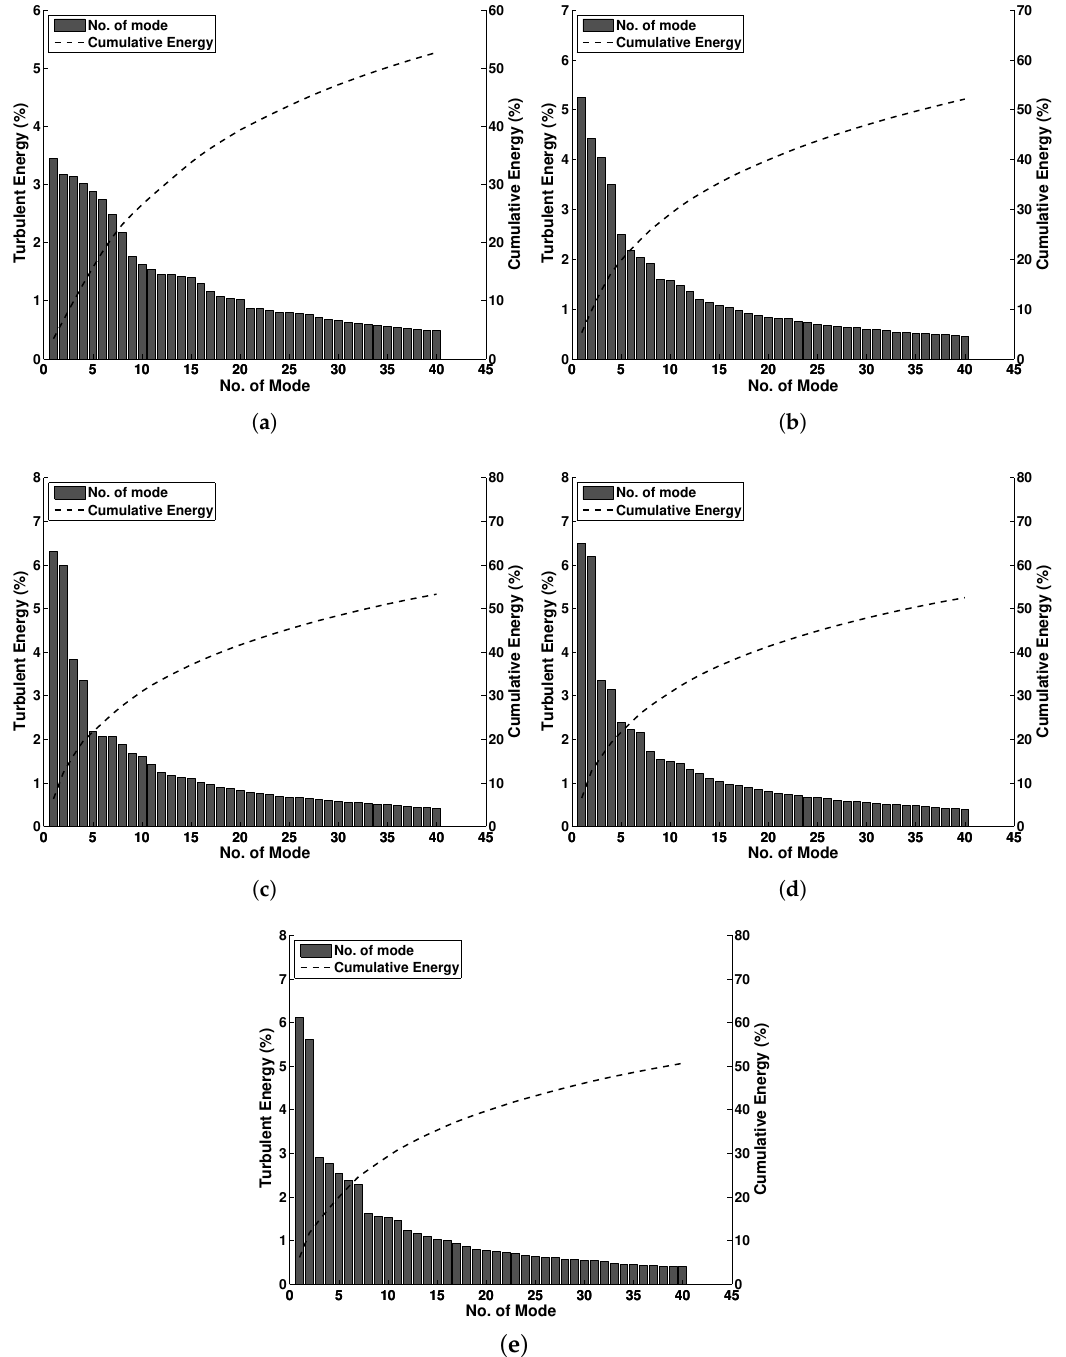
Figure 2. Relative and cumulative turbulent energy distribution in the Proper Orthogonal Decomposition (POD) eigenmodes at ( a ) x / D = 5, ( b ) x / D = 10, ( c ) x / D = 15, ( d ) x / D = 20, and ( e ) x / D =